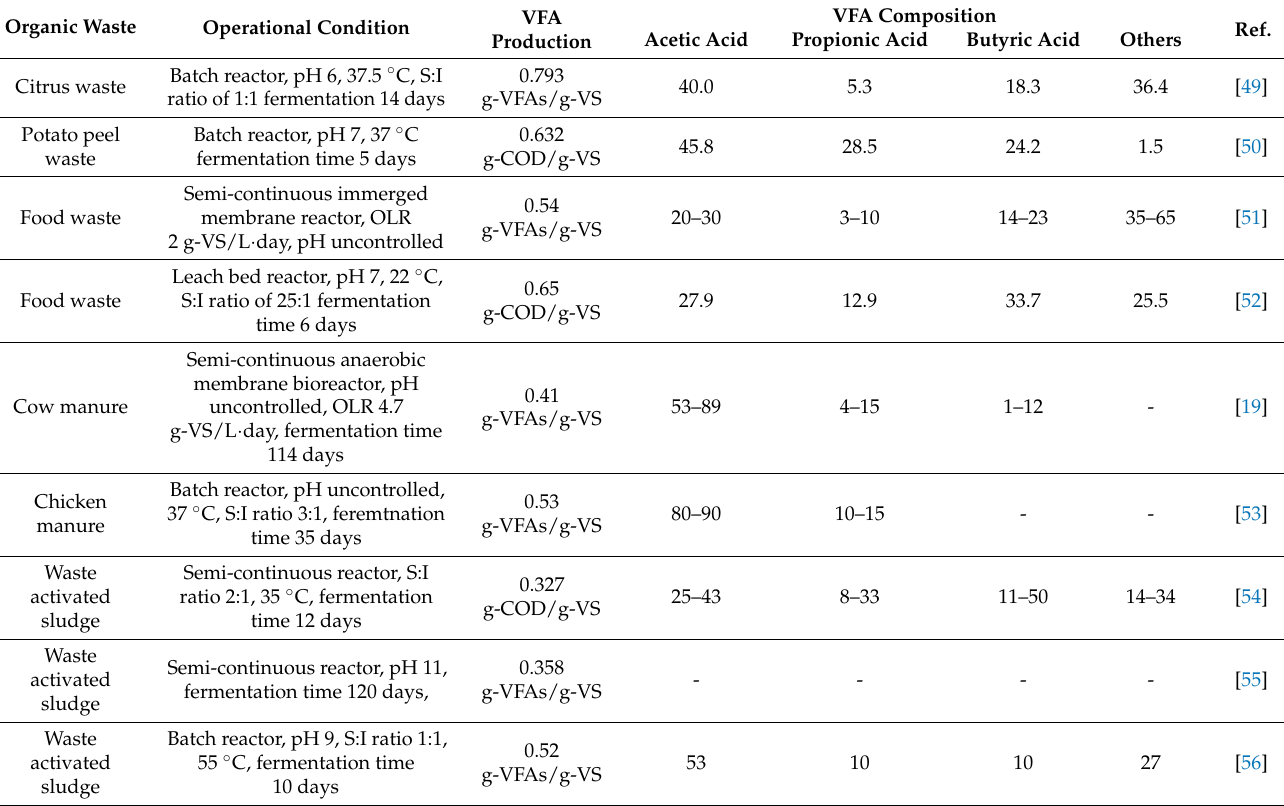
Table 1. Various organic waste as the substrate for acidogenic